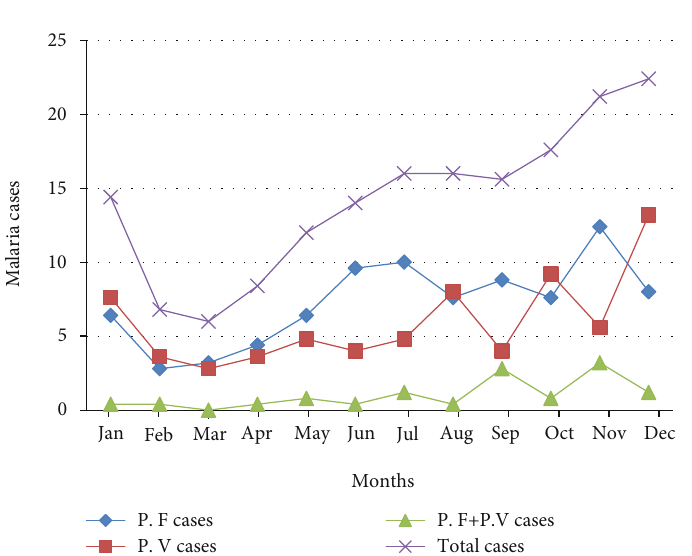
Figure 2: Average monthly variation of total malaria cases and species from 2015 to 2019. P. F: Plasmodium falciparum ; P. V: Plasmodium vivax. Table 3: Number of malaria cases among age and sex from 2015 to 2019.